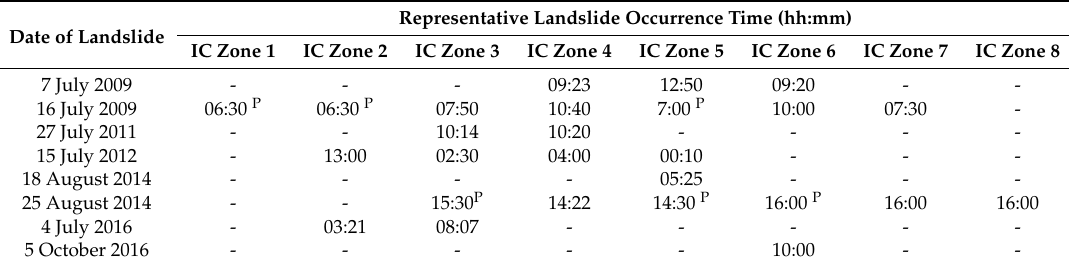
Table 4. Representative landslide occurrence times per infiltration characteristic (IC) zones in which landslides occurred on the eight landslide event